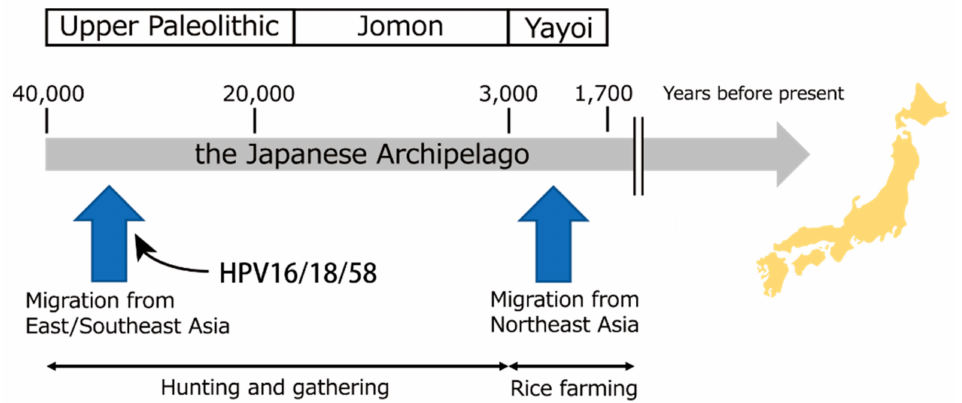
Figure 7. Timeframe of migration of ancestral Japanese populations into the Japanese archipelago and co-migration of Japan-specific HPV16/18/58